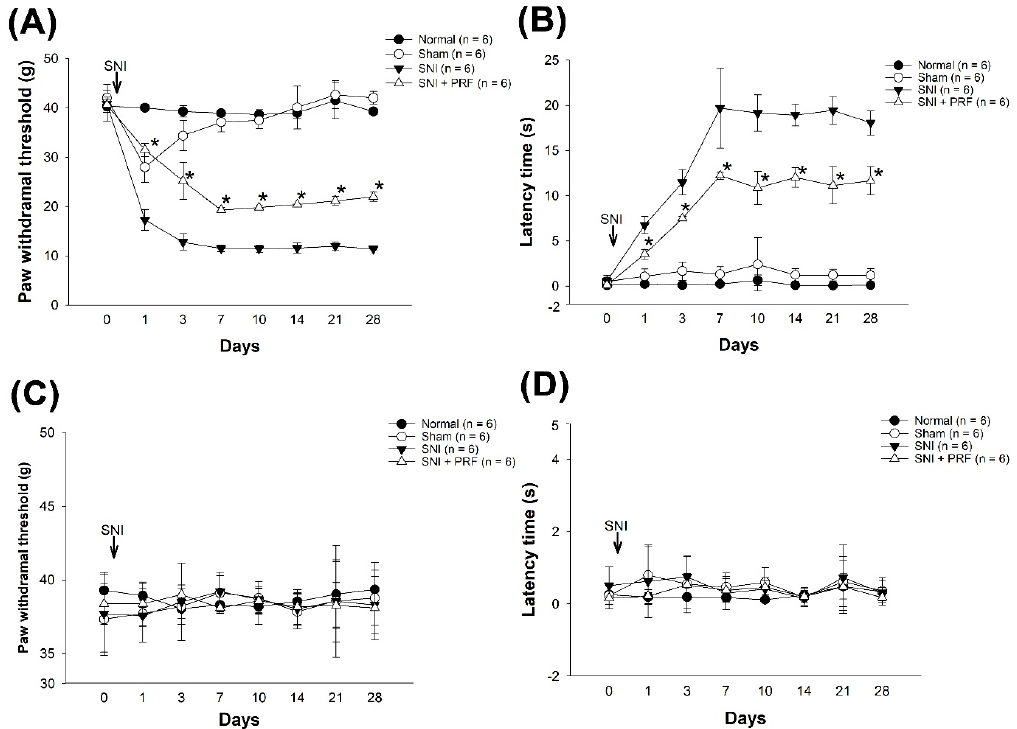
Figure 2. ( A ) Paw withdrawal threshold (PWT) for the mechanical allodynia test. Rats were randomly divided into 4 groups ( n = 6): a normal control group ( • ), a sham group ( ), an SNI group ( (cid:72) ), and an SNI + PRF group ( (cid:52) ). Mechanical allodynia was examined using a dynamic plantar aesthesiometer. * p <0.05, the SNI + PRF group compared with the SNI group. ( B ) Paw withdrawal time for the cold allodynia test. Behavioral response in the 4 groups. Cold allodynia was evaluated by the acetone spray test. * p <0.05, the SNI + PRF group compared with the SNI group. ( C ) Contralateral side of PWT for the mechanical allodynia test. ( D ) Contralateral side of the paw withdrawal time for the cold allodynia